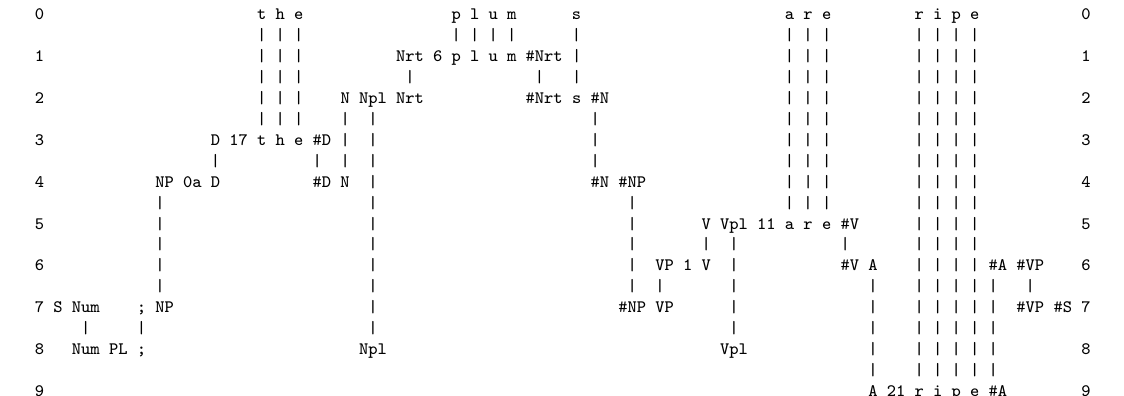
Figure A2. The best SPMA created by the SPCM that achieves the effect of parsing a sentence (‘ t h e p l u m s a r e r i p e ’) into its parts and sub-parts, as described in the text. The sentence in row 0 ia a New SP-pattern, while each of the rows 1 to 9 contains a single Old SP-pattern, drawn from a repository of Old